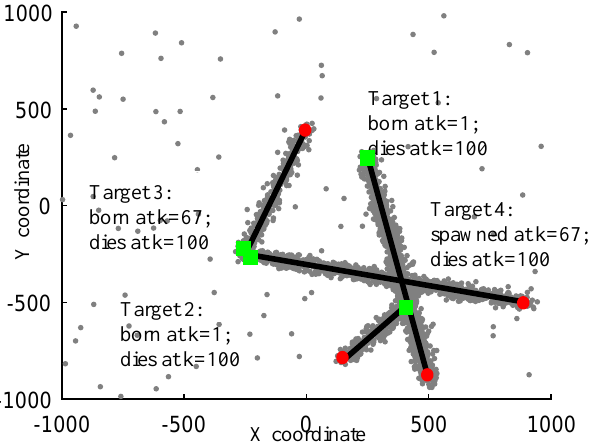
Figure 3. True tracks and measurements with clutter. Green square is the beginning point of the track; red circle is the end point of the